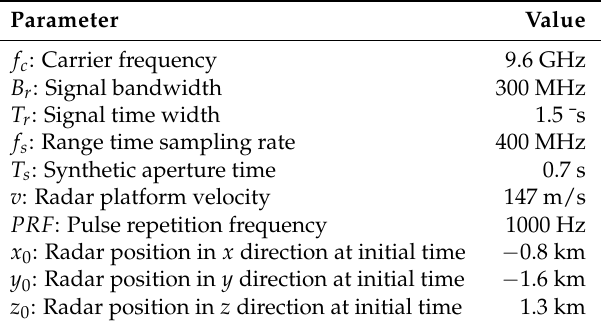
Table 3. Experimental